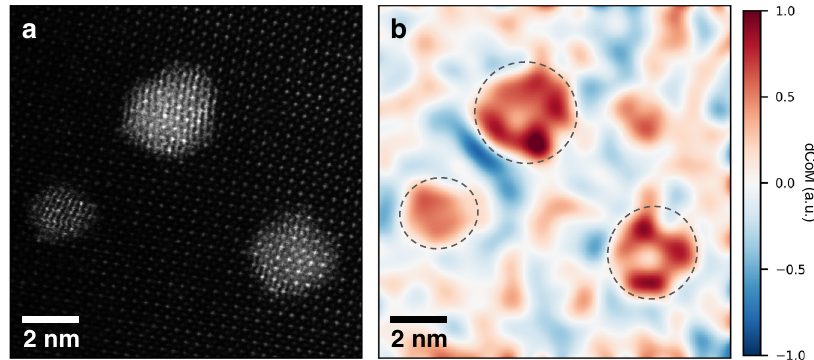
Fig. 4 Effect of O-treatment on charge transfer as measured by dCoM 4D-STEM. a HAADF image of an O-treated Au-STO catalyst taken before the 4D- STEM map. b Charge density map of the catalyst particles after application of a 4 Å Gaussian fi lter to the original atomic-resolution inverted dCoM map (shown in Supplementary Fig. 1). In the O-treated case, the particles appear positive in projection, with a negative region in the surrounding support. Much of the positive charge appears near the perimeter of